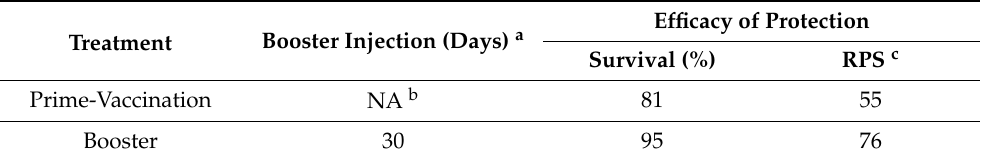
Figure 5. Protection conferred by the vaccination/re-immunization and decrease of the viral load in sole brains. ( A ) percent of survival during 30 days of in vivo infection and ( B ) viral load (n =3 fish/group and time) in brain from challenged Senegalese sole specimens. ( A ) Survival rates were compared between groups using the Kaplan Meier test. Asterisks denote differences between survival curves according to a log-rank Mantel Cox test ( p < 0.001), ( B ) Infection was performed by intramuscular injection with 2 × 10 4 TCID 50 /g. Asterisks represent statistical differences between control and prime-vaccinated/booster groups whereas hash symbols represent significant differences between prime- and booster-vaccinated groups at a same time point ( p < 0.05). Table 2. Immunization conditions and conferred protection against NNV infection after 30 days post